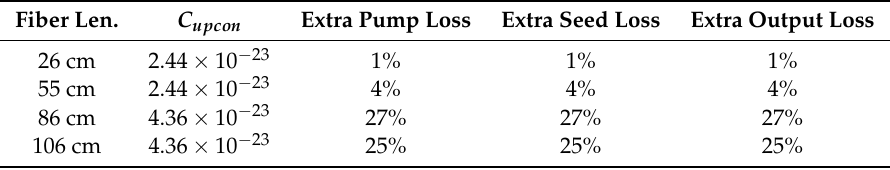
Table 5. Simulation parameters used for all fibers in the FLAT